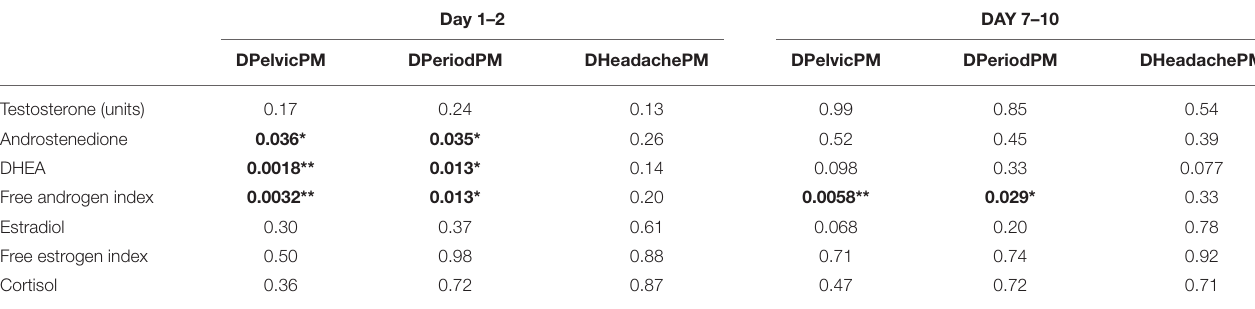
TABLE 1 | Comparison of significance ( p -value) between androgen and estrogen levels and Days per Month of Pelvic Pain (DPelvicPM), Period Pain (DPeriodPM) and Headache (DHeadachePM) on Day 1–2 and Day 7–10 of the menstrual cycle in women not using the contraceptive